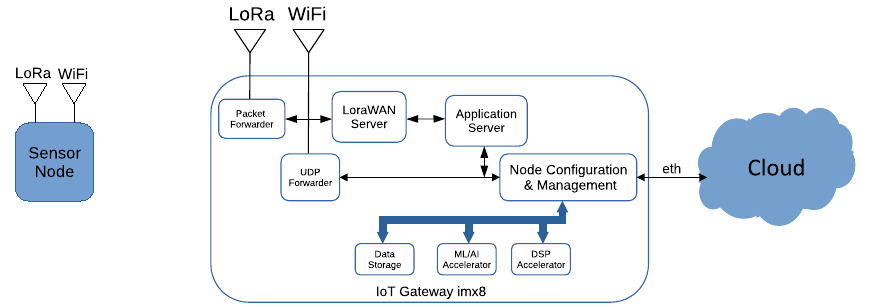
Figure 8. The IoT gateway software architecture with the LoRaWAN server